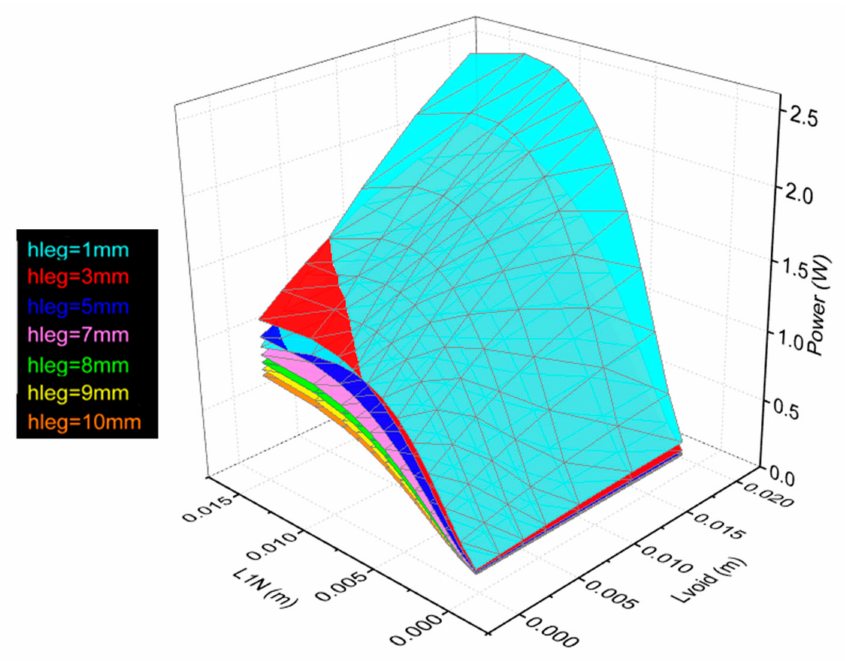
Figure 15. Matched power per pair as a function of n-type diameter, L 1 N , and element spacing, L void , for several element thicknesses, h leg